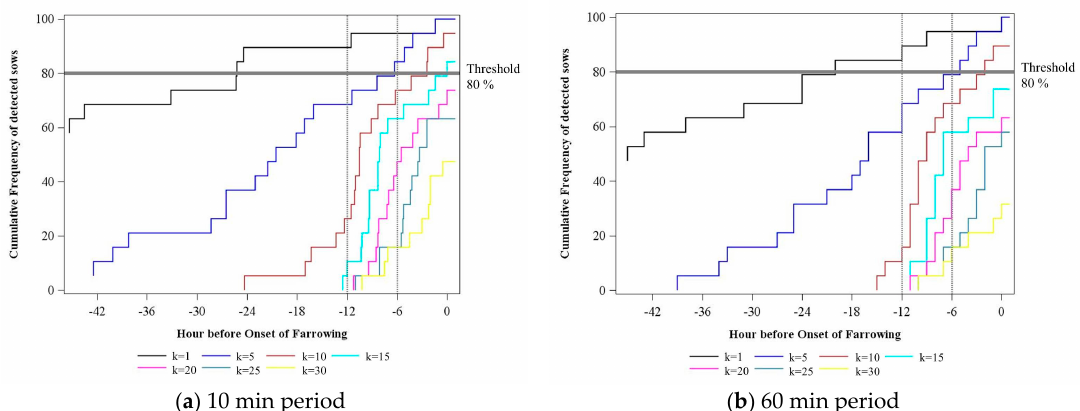
Figure 6. Cumulative sum of the number of sows detected within the whole prediction period exemplarily for the 10 and 60 min period. Time window from Hour − 6 to Hour − 12 is marked.